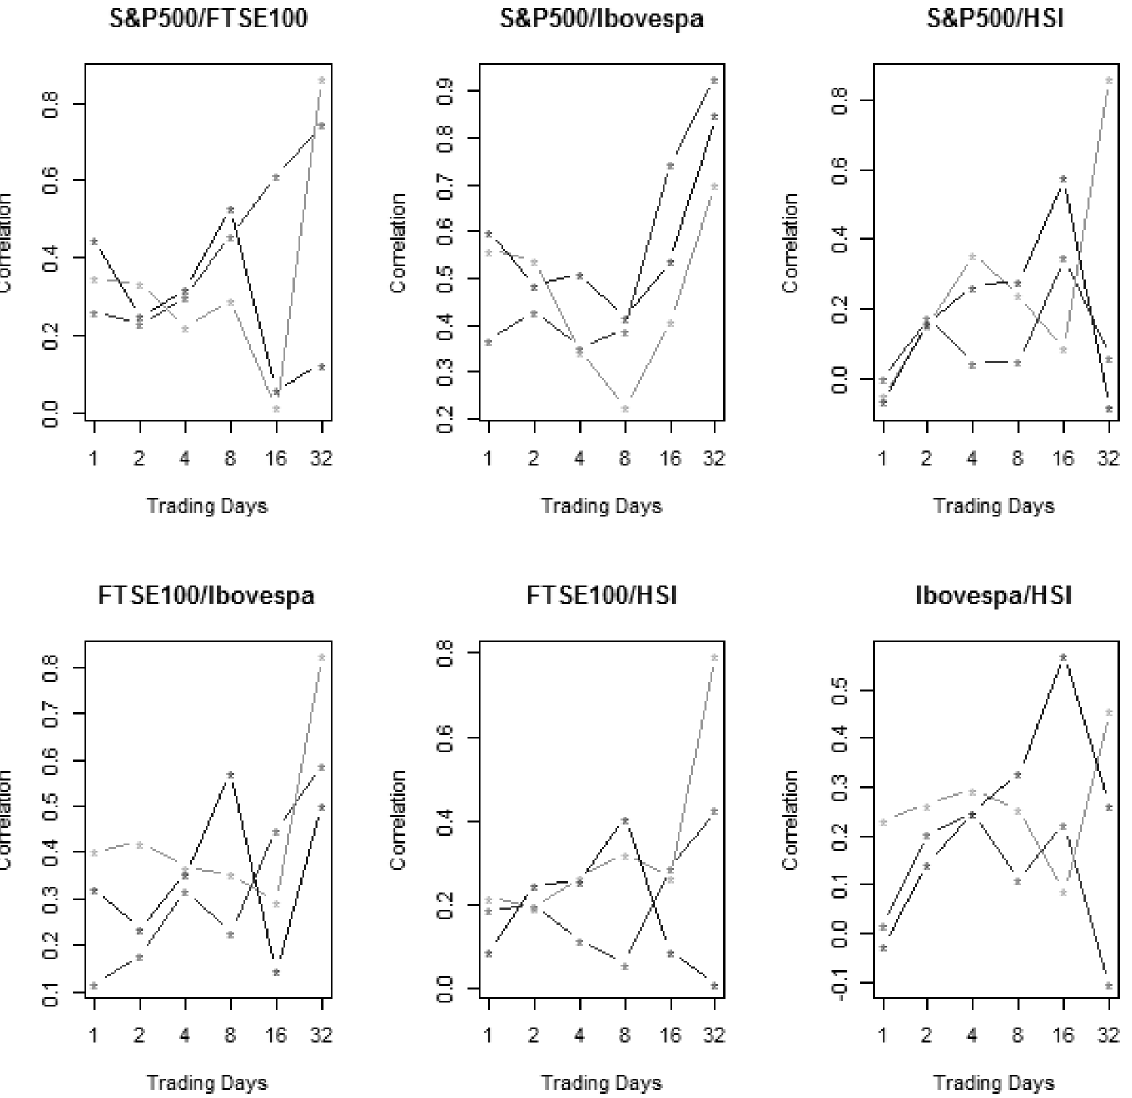
Figure 6. Correlation for S&P500, FTSE100, Ibovespa and HSI wavelet coefficients relationships in non-crisis (middle gray), Sub- prime crisis (weak gray) and Eurozone crisis (strong gray).